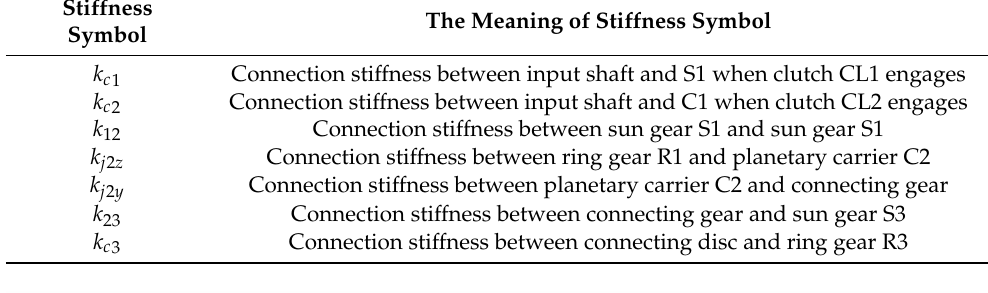
Table 1. The meanings of each connection stiffness in Figure 6.